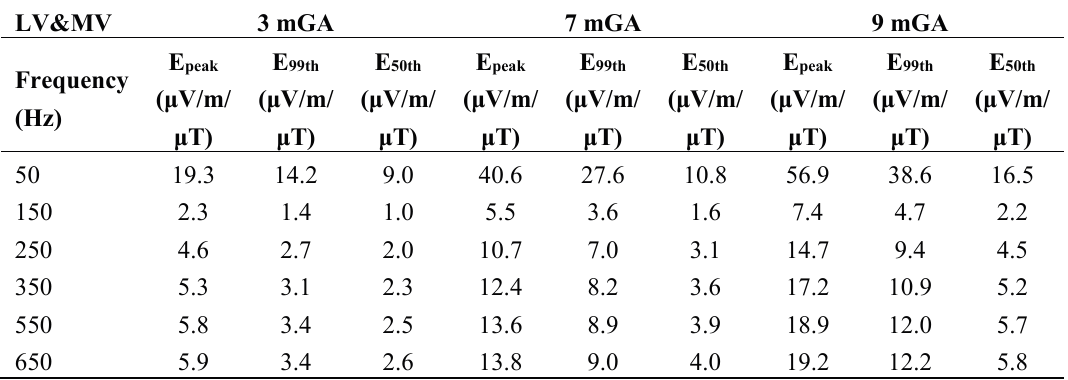
Table 4. Whole-body foetus induced electric field E peak , E 99th and E 50th at 3, 7 and 9 months GA, for each frequency, per μ T of B peak,50Hz, calculated according to the percentage provided by the standard EN 50160 in case of LV or MV electricity distribution networks exposure.